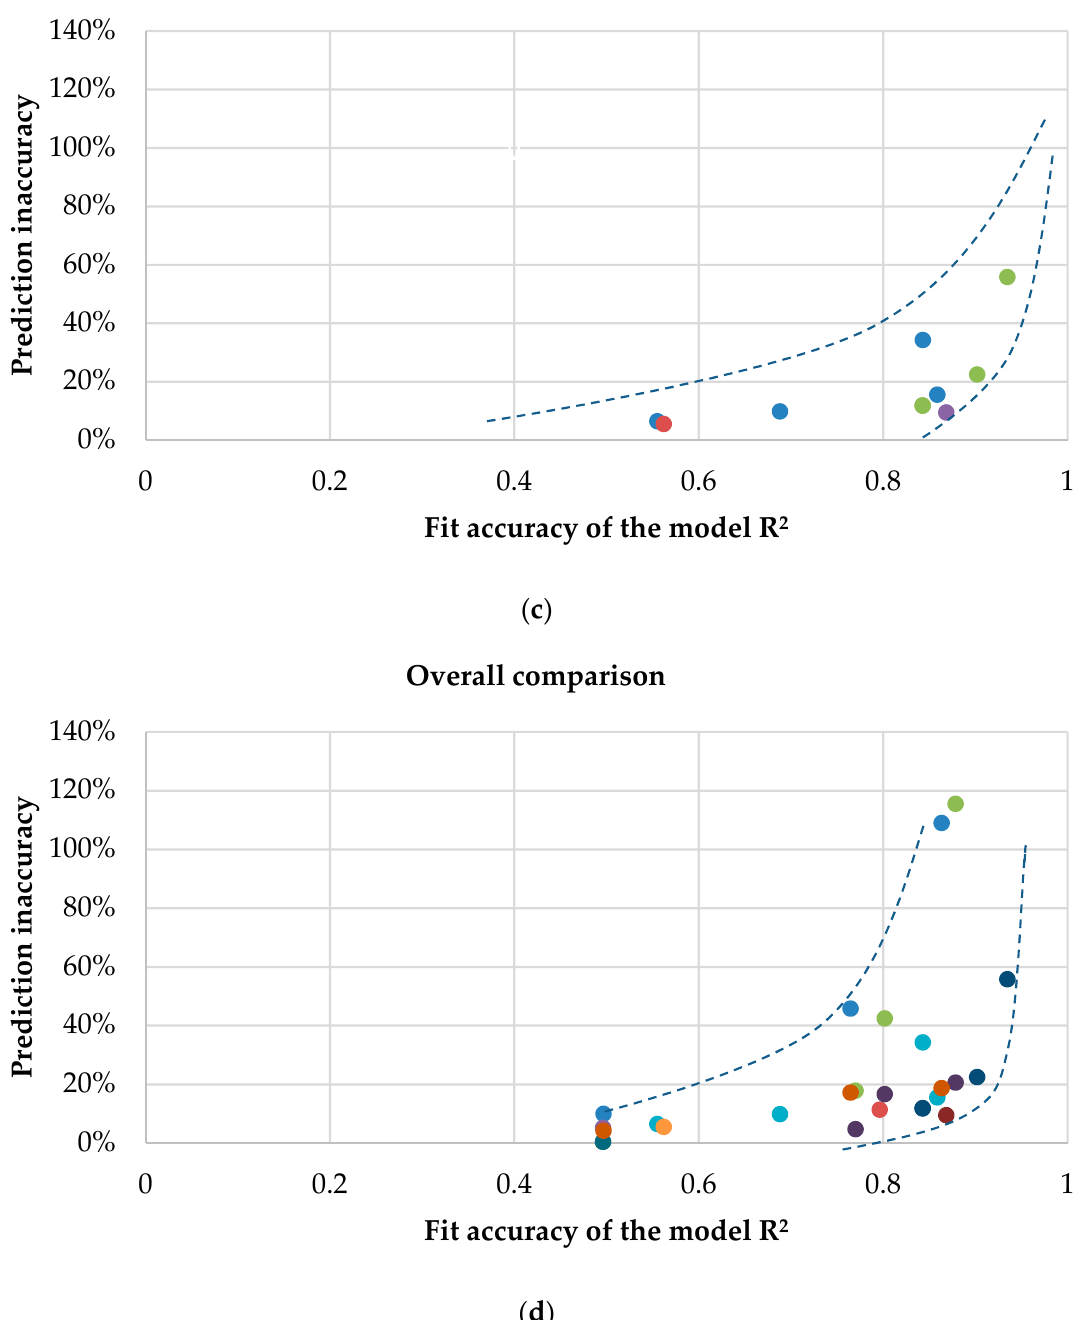
Figure 8. A comparison of R 2 of the model and the absolute value of the degree of inaccuracy of the modeled compressive strength for different variants of contamination and different ranges of the teaching data for the model: ( a ) 8% contamination from the model taught in the range of 0–6%, ( b ) 10% contamination from the model taught in the range of 0–6%, ( c ) 10% contamination from the model taught in the range of 0–8%, and ( d ) an overall comparison.